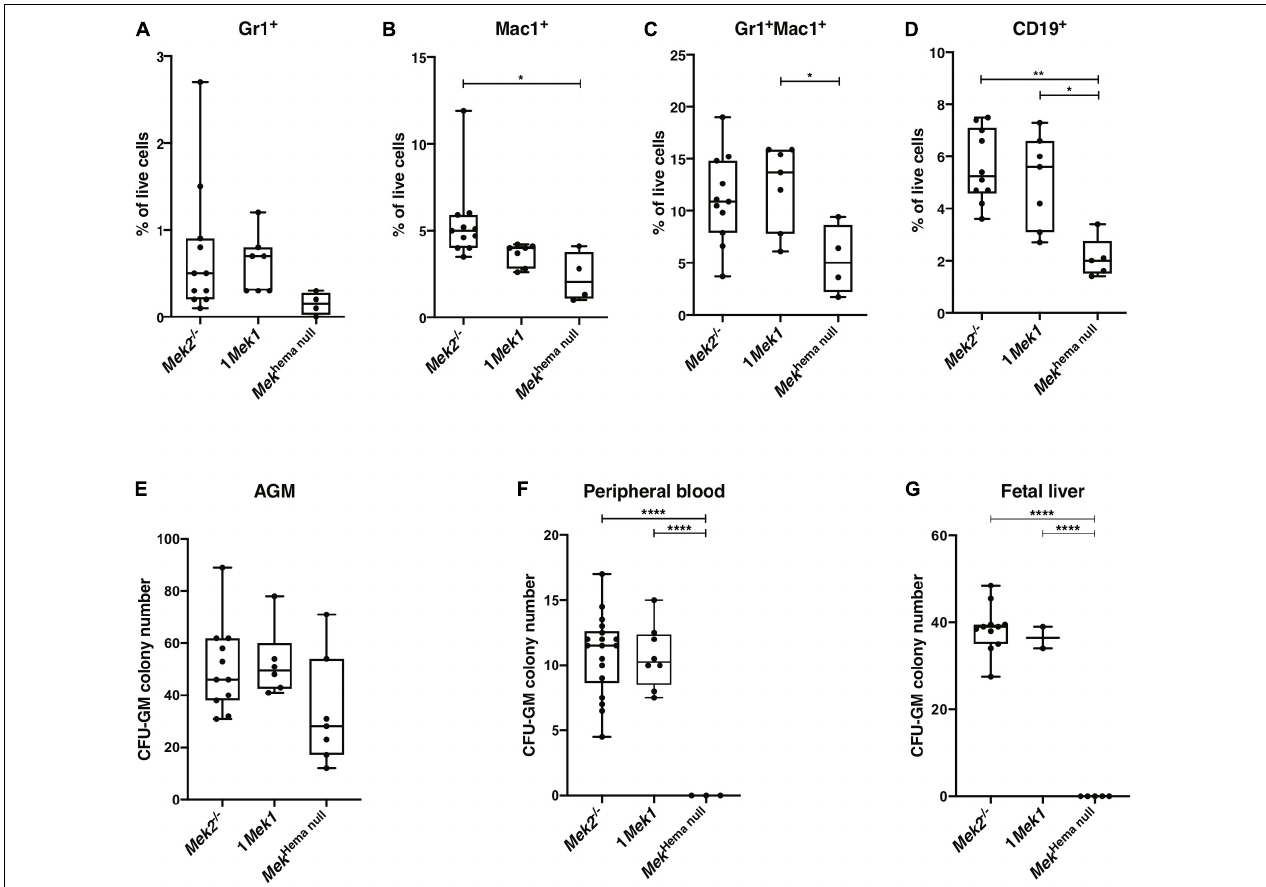
FIGURE 3 | Hematopoiesis cell populations affected in Mek hema null mutants. (A–D) Flow cytometry analyses of newborn spleen revealed a decreased in the proportion of Gr-1 + (A) , Mac1 + (B) , Mac1 + Gr-1 + (C) , and CD19 + (D) cells in Mek hema null mutants compared to control animals. (E–G) Numbers of CFU-GM colonies obtained after in vitro growth of E10.5 AGM region (E) , E12.5 peripheral blood cells (F) , and E14.5 fetal liver cells (G) from controls and Mek hema null embryos are presented. A gradual loss of erythroid and myeloid cell progenitors occurred in Mek hema null embryos during gestation. The results are presented as whiskers-and-boxes graph, and each dot represents an individual mouse. ANOVA with Kruskal–Wallis multiple-comparisons test was performed. * P < 0.05, ** P < 0.01, **** P <